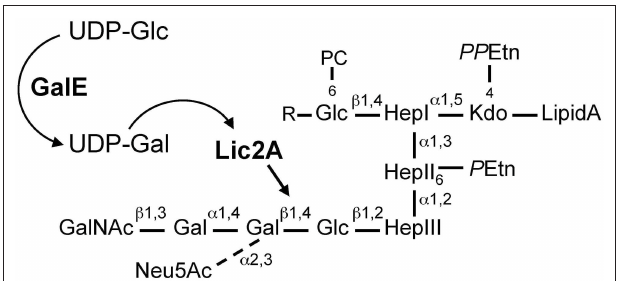
FIGURE 1 | H. influenzae Rd LOS. GalE generates UDP-Gal for galactose extension by Lic2A. Diagram is based on structural information as